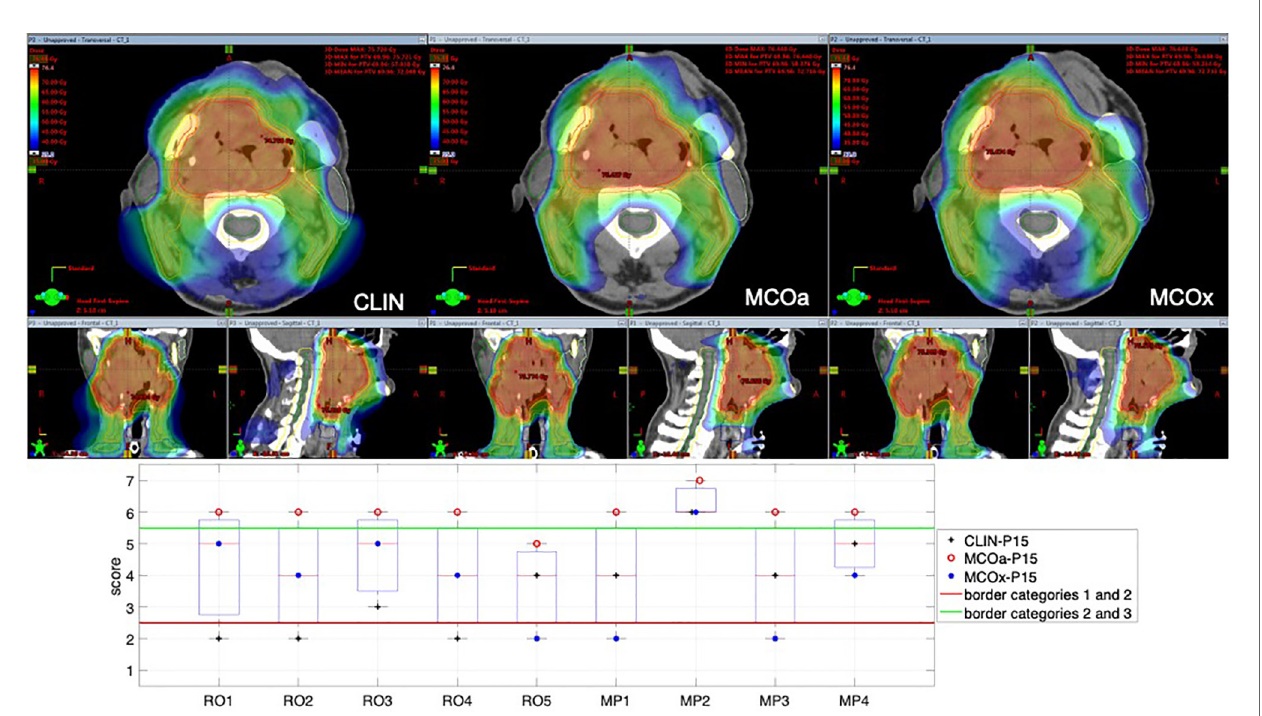
FIGURE 1 | Differences in subjective plan scores among the nine observers in the study, illustrated with an example patient (patient 15). Top panels: dose distributions of the evaluated CLIN, MCOa, and MCOx plans in axial, sagittal, and frontal planes. Bottom panel: corresponding subjective plan quality scores for the CLIN, MCOa, and MCOx plans of patient 15 for each of the nine observers, fi ve ROs (RO1 – RO5), and four MPs (MP1 – MP4). Plans below the horizontal red line are considered unacceptable (raw scores 1 and 2, category 1). Above the green line are plans that can straightaway be delivered without any attempt to further improve the plan (raw scores 6 and 7, category 3). In the middle are the plans that are acceptable if further planning would not result in signi fi cant improvements (raw scores 3 – 5, category 2). CLIN, clinical; RO, radiation oncologist; MP, medical